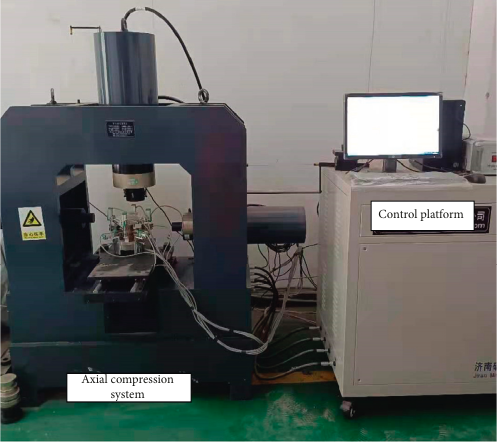
Figure 5: Large-scale indoor rock testing machine, YZW-100 mine rock mass testing experimental equipment